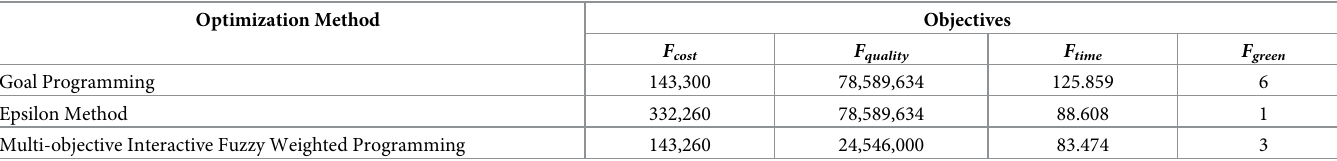
Table 21. Comparison of different optimization methods.